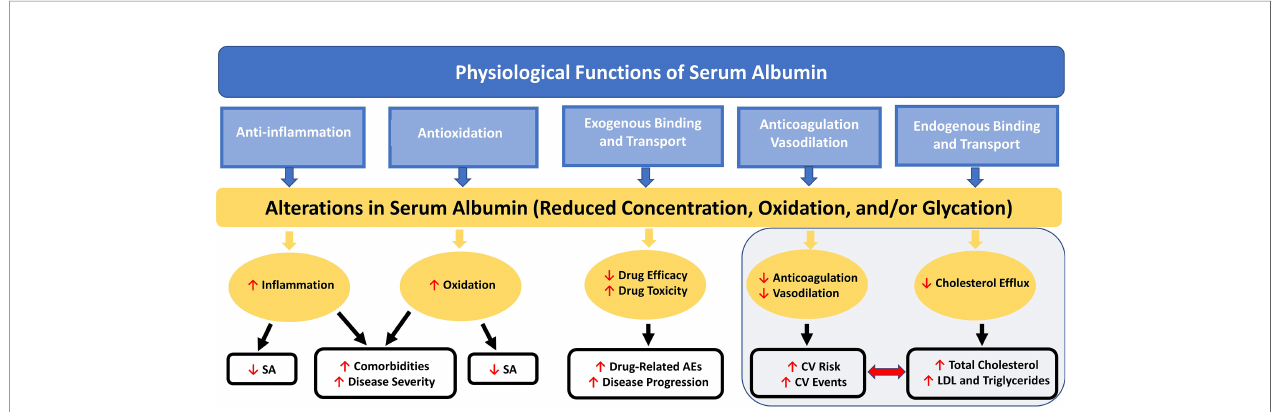
FIGURE 2 | Nononcotic Pressure Functions of Serum Albumin and Consequences of Alterations in Concentration on Aspects of Health and Disease. Schematic representation of the interactive effects among the physiological functions (not including colloid oncotic pressure) of SA and the processes by which alterations in SA can lead to further decreases in SA concentration and to increases in disease severity and comorbidities; total cholesterol, LDL, and triglyceride levels; CV risk and events; and drug-related AEs. AE, adverse event; CV, cardiovascular; LDL, low-density lipoprotein; SA, serum